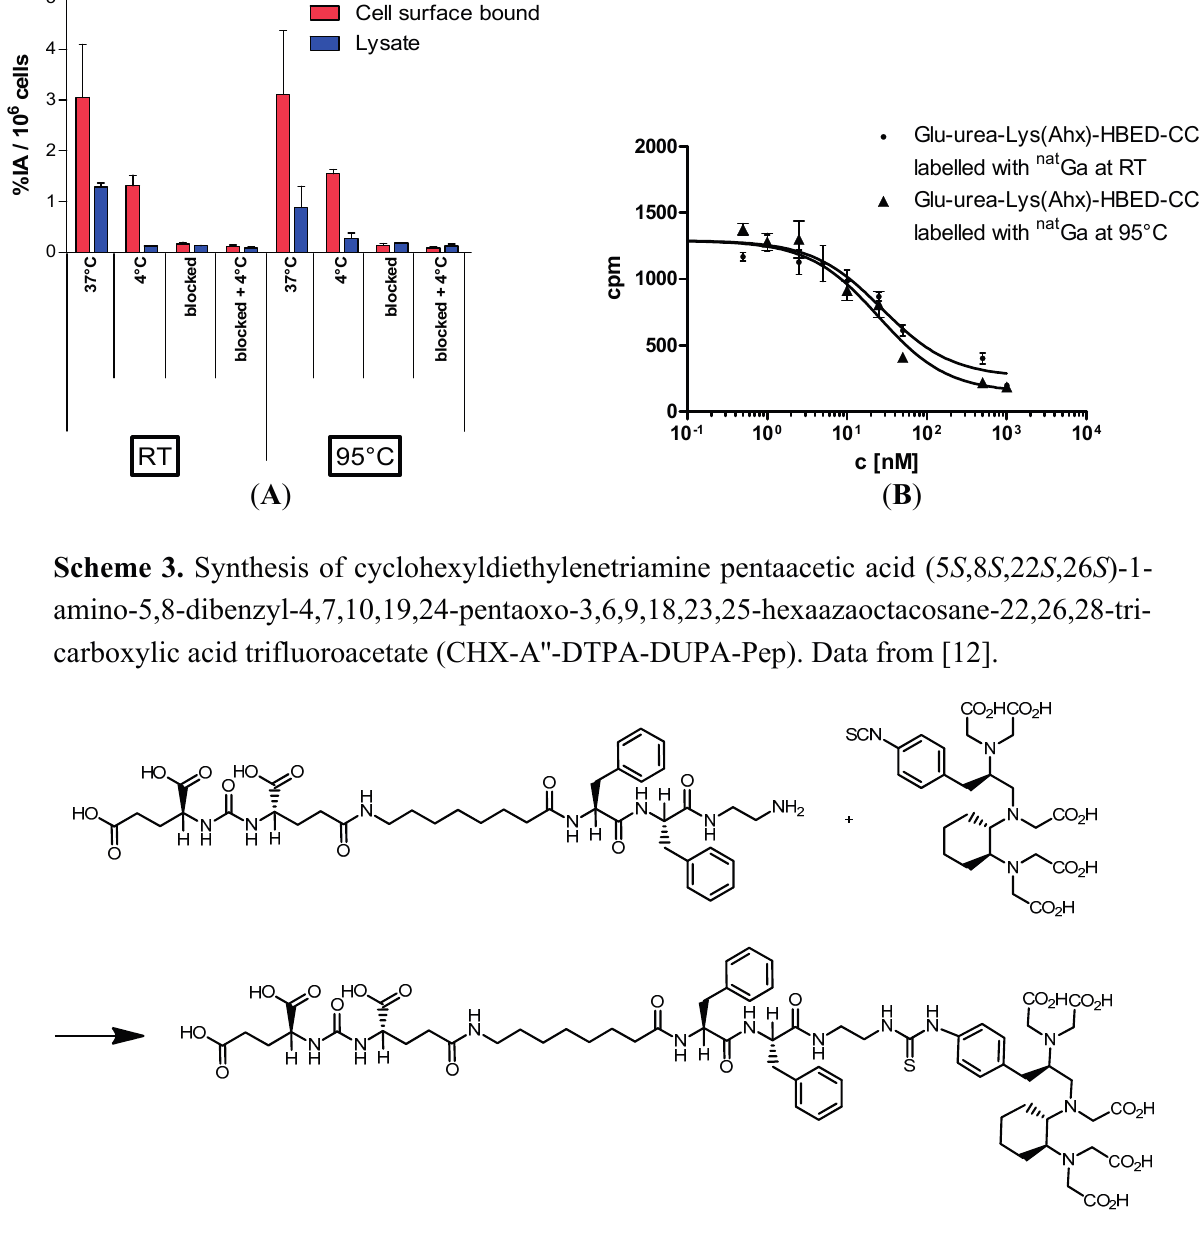
Figure 6. ( A ) LNCaP-cell binding and internalisation of [ 68 Ga]Ga-PSMA-HBED-CC labelled at RT or 95 °C, respectively. Specific cell uptake was determined by competitive blockade with 500 µM of the PSMA inhibitor 2-PMPA. Values are expressed as percentage of applied radioactivity bound to 10 6 cells [%IA/10 6 cells]. Data are expressed as mean ± SD ( n = 3); ( B ) Determination of binding affinity of [ nat Ga]Ga-PSMA-HBED-CC to LNCaP cells as a function of the labelling temperature. The cells (10 5 per well) were incubated with the radioligand ( 68 Ga-labelled Glu-urea-Lys(Ahx)-HBED-CC) in the presence of different concentrations of nat Ga-analyte (0–5000 nM, 100 µL/well). Data from [11].